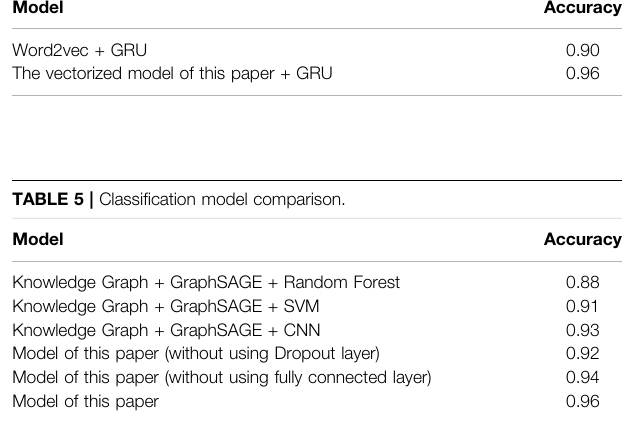
TABLE 4 | Vector generation model comparison. Model